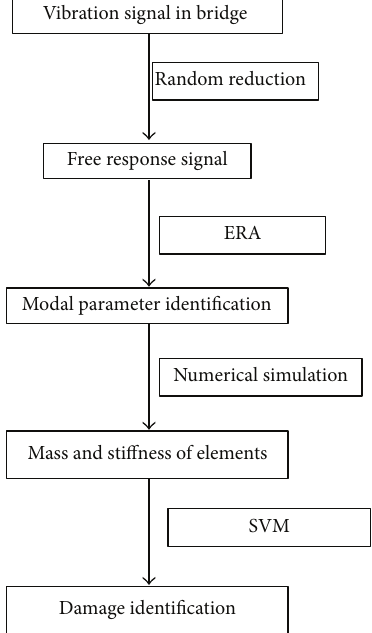
Figure 2: Schema of whole